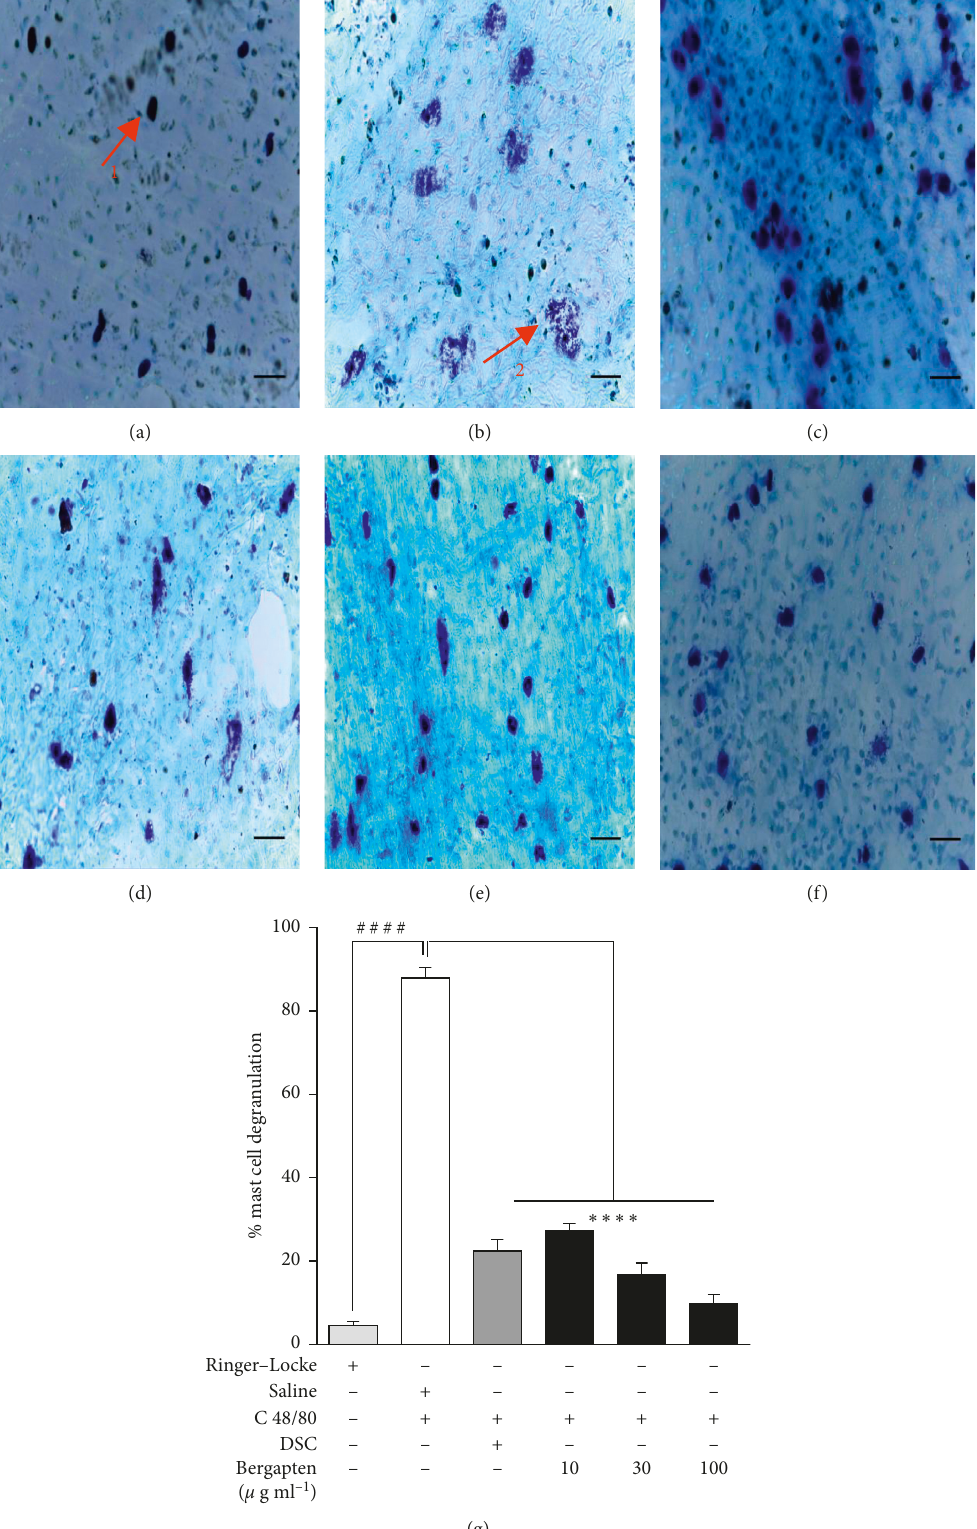
Figure 1: Effect of bergapten on C48/80-induced rat mesenteric mast cell degranulation. A Sprague Dawley rat was sacrificed; pieces of its mesentery excised and treated with either Ringer–Locke (a), normal saline 10ml kg − 1 (b), disodium cromoglycate, DSC 10 μ gml − 1 (c), or bergapten 10, 30 and 100 μ gml − 1 , respectively (d–f). Tissues except the na¨ıve control were challenged with C48/80 (1 μ g) for 15min and stained with Toluidine blue (0.1%, pH 2.5) for 30 min. Representative micrographs of stained mast cells are shown (a–f) and degranulation quantified (g). Data are expressed as mean ± SEM ( n � 5). ∗∗∗∗ p < 0 . 0001 compared to the saline-treated C48/80-challenged group. #### p < 0 . 0001 compared to naive control group (One-way ANOVA followed by Dunnett’s post hoc test). Micron bar represents 100 μ